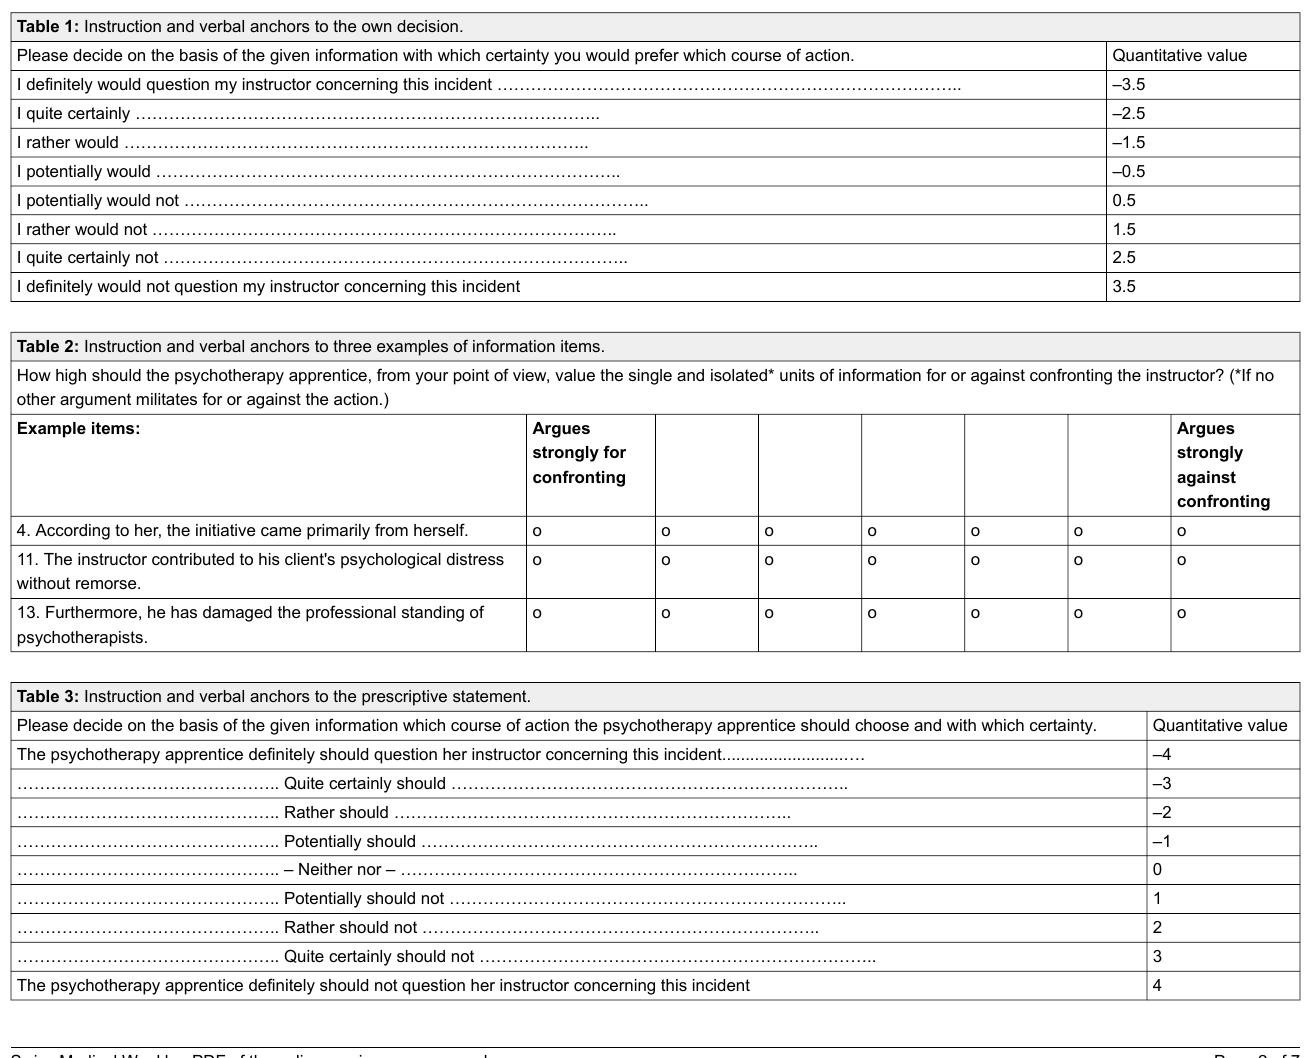
Table 1: Instruction and verbal anchors to the own decision. Please decide on the basis of the given information with which certainty you would prefer which course of action. Quantitative value